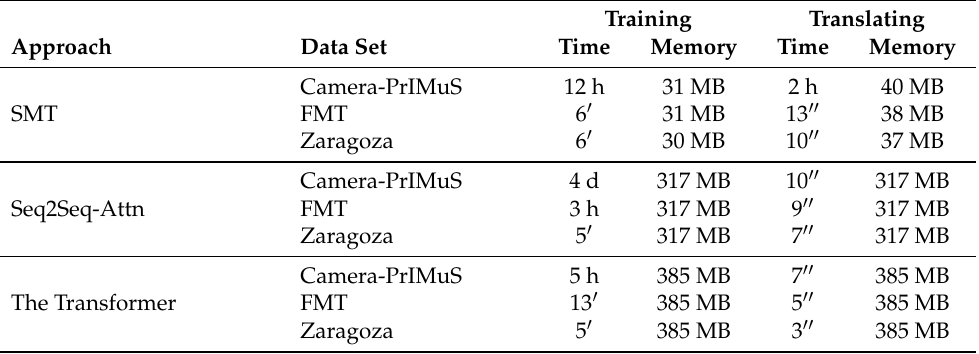
Total time and peak memory consumed by each the three approaches evaluated (SMT, Seq2Seq-Attn, and the Transformer) to train and to translate one fold of each of the three datasets used for evaluation (Camera-PrIMuS, FMT, and